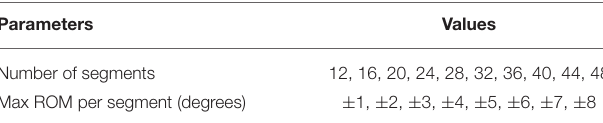
TABLE 1 | The different continuum joint parameters and their values that were simulated.